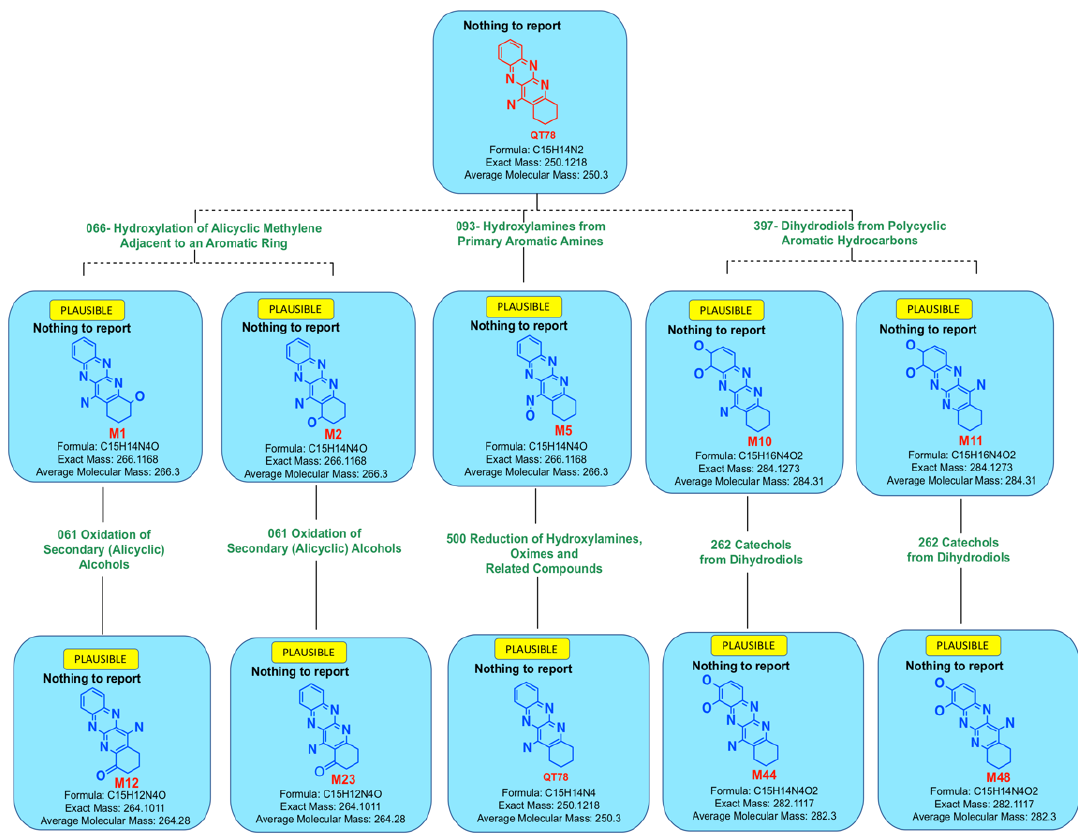
Figure 2. Summary metabolic tree after processing QT78 (query compound) for human Phase I biotransformation reactions and two sequences of biotransformation.